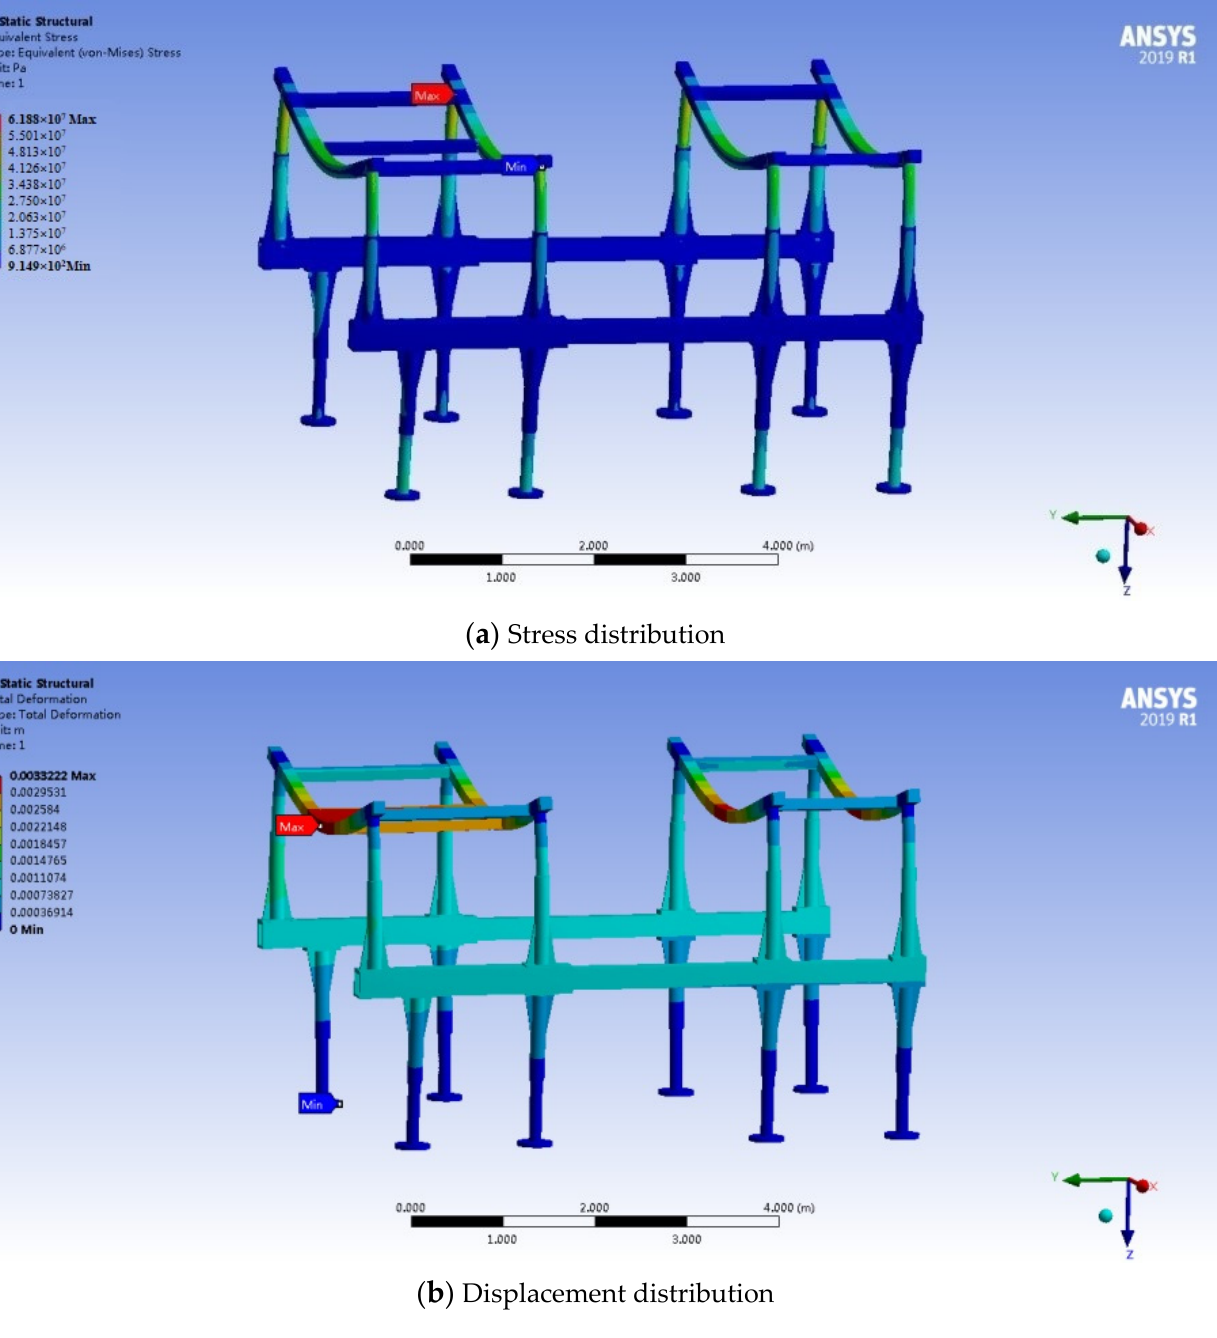
Figure 5. Stress and displacement distribution of the advance support under the normal external